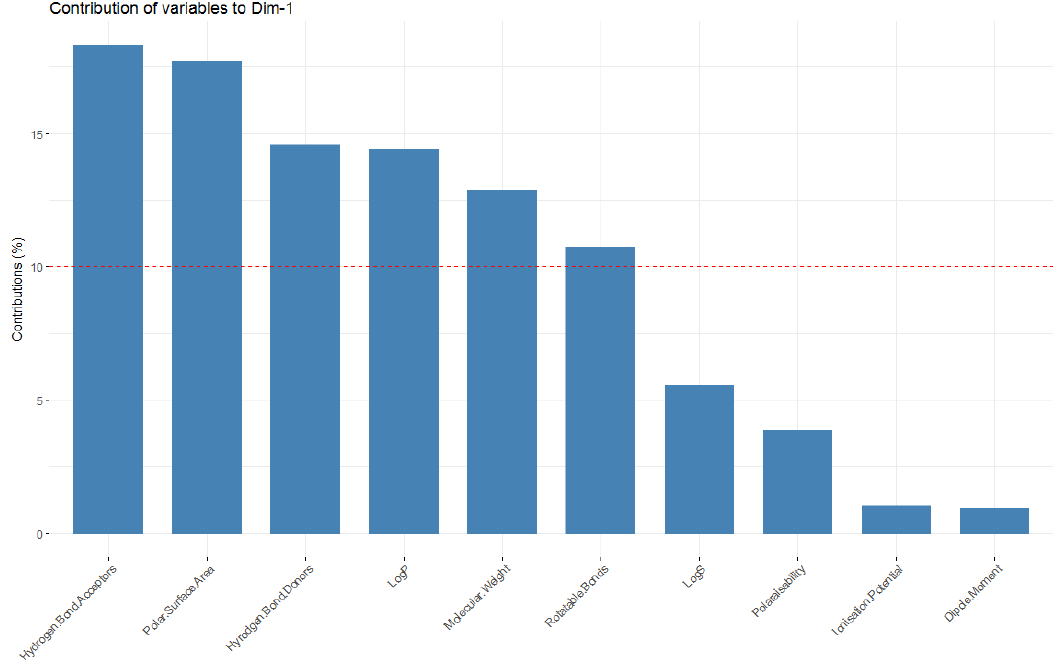
Figure 10. Representation of the contributors to the first principal component.